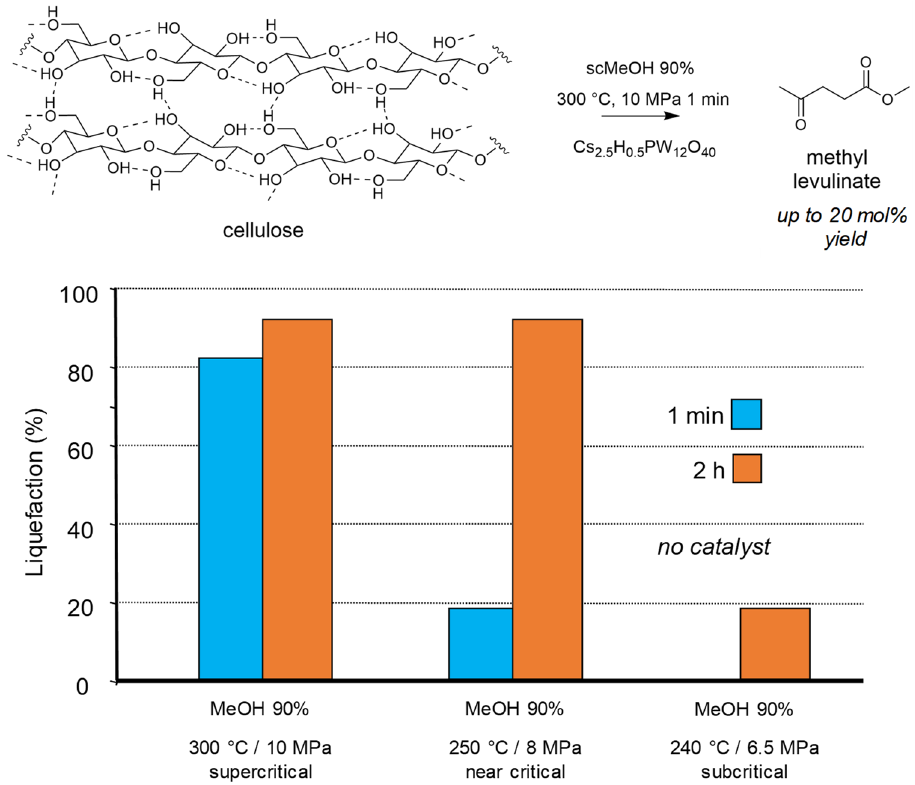
Figure 2. Cellulose transformation into methyl levulinate in supercritical MeOH (methanol 90 wt% 25 g, cellulose 0.35 g, catalyst if present 0.15 g). Yield = 100 × (n product /n glucosyl units ) × (5/6). Adapted from [71].